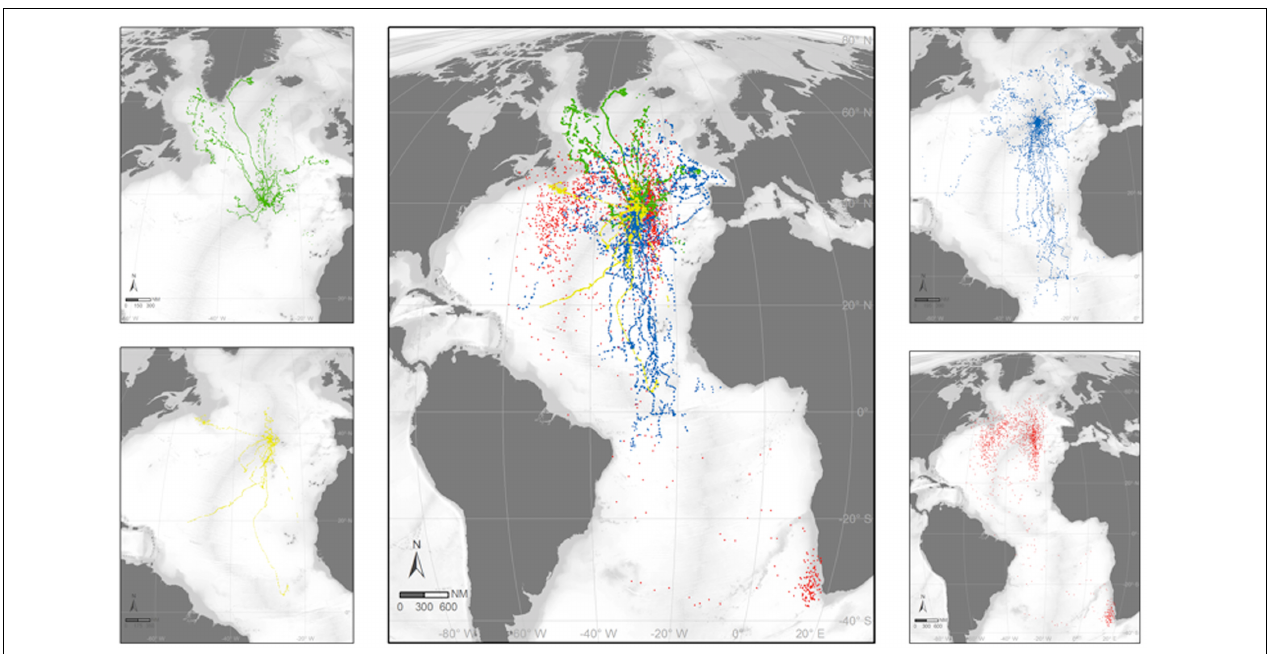
FIGURE 1 | Graphic representation of various megafauna tracks obtained via satellite tagging programs implemented in the Azores archipelago. Dots represent estimated positions from individual baleen whales (green), seabirds (red), and large pelagic teleost (yellow) and cartilaginous (blue) fishes. Redrawn from data in published (see text) and unpublished reconstructed geolocations, GPS-logged or ARGOS